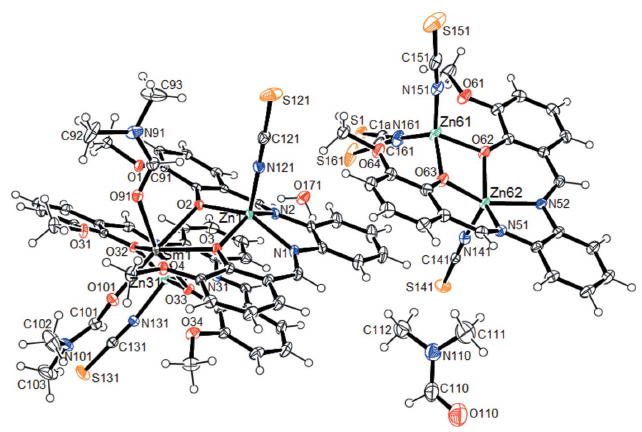
Figure 1 An ORTEP view of the asymmetric unit of the title compound, showing the atom-numbering scheme. Displacement ellipsoids are plotted at the 50% probability level.